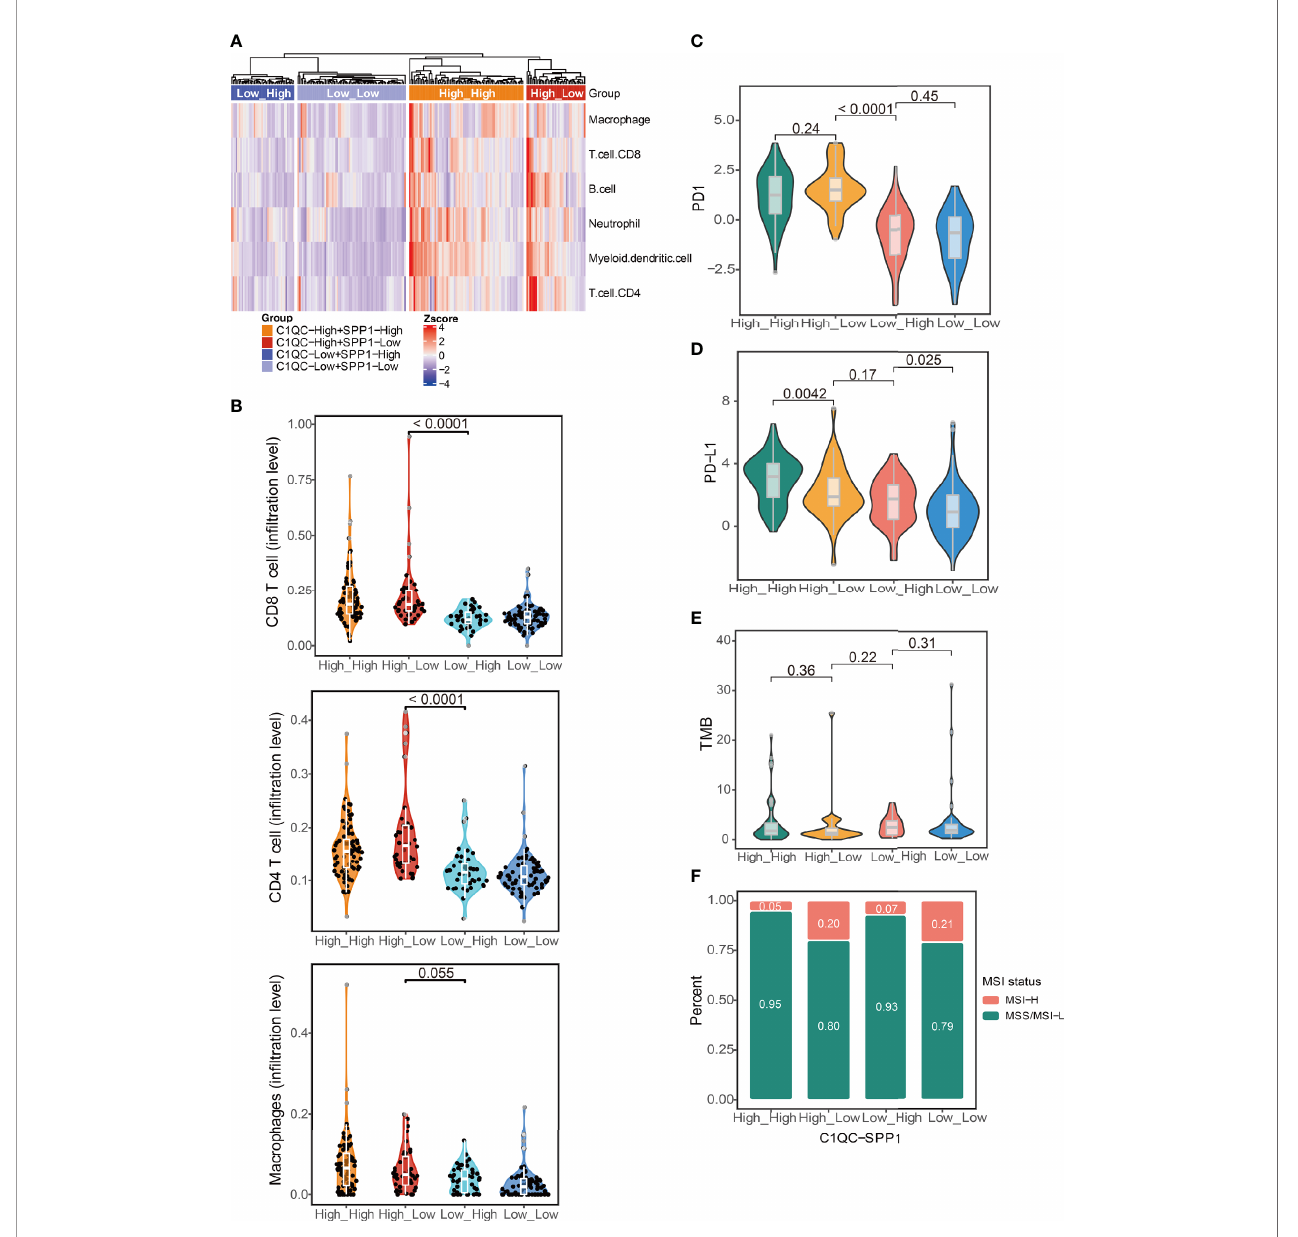
FIGURE 3 | Immune characteristics in different groups of TCGA cervical cancer patients. (A) Heatmap showing immune cell signatures by TIMER in cervical cancer patients grouped by the gene signature expression of C1QC + TAM and SPP1 + TAM. (B) Violin plots showing comparison of CD8 T cell, CD4 T cell, and macrophages gene signatures among cervical cancer patients grouped by the gene signature expression of C1QC + TAM and SPP1 + TAM. Two-sided Wilcoxon test. (C) Violin plots showing comparison of PD1 gene expression among cervical cancer patients grouped by the gene signature expression of C1QC + TAM and SPP1 + TAM. Two-sided Wilcoxon test. (D) Violin plots showing comparison of PD-L1 gene expression among cervical cancer patients grouped by the gene signature expression of C1QC + TAM and SPP1 + TAM. Two-sided Wilcoxon test. (E) Violin plots showing comparison of TMB among cervical cancer patients grouped by the gene signature expression of C1QC + TAM and SPP1 + TAM. Two-sided Wilcoxon test. (F) Proportions of patients with MSI-H and MSS/MSI-L state in cervical cancer patients grouped by the gene signature expression of C1QC + TAM and SPP1 +